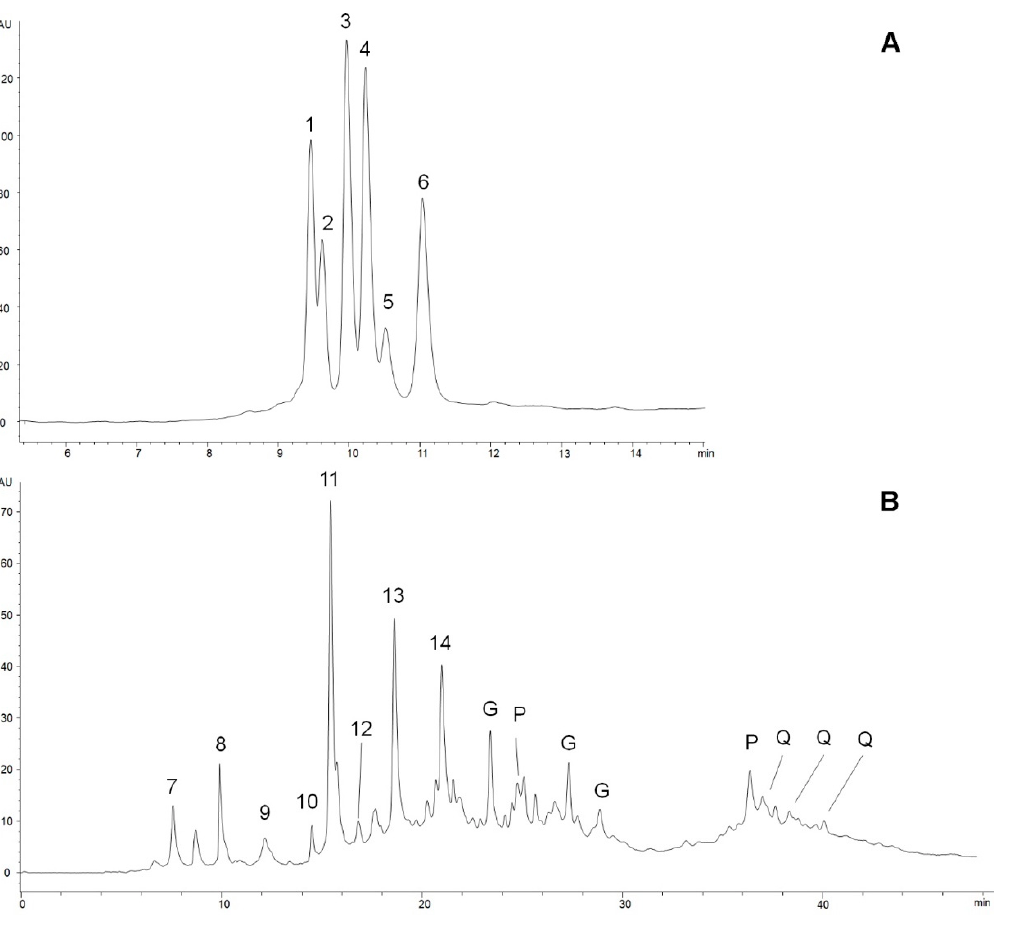
Figure 2. Chromatographic profiles of the OFS extracts (see Section 2). ( A ) pH 1.9, acquired at 520 nm: Anthocyanosidic compounds. 1. Cyanidin 3- O -galactoside; 2. Cyanidin 3- O -glucoside; 3. Cyanidin 3- O -arabinoside; 4. Peonidin 3- O -galactoside; 5. Peonidin 3- O -glucoside; 6. Peonidin 3- O -arabinoside. ( B ) pH 3.2, acquired at 280nm. Non-anthocyanosidic polyphenols. 7. Vescalin; 8. Castalin; 9. Pedunculagin I; 10. Monogalloyl glucose I; 11. Gallic acid; 12. Monogalloyl glucose II; 13. Vescalagin; 14. Castalagin; G. Gallic acid derivatives; P. Proanthocyanidins; Q. Quercetin deriv- atives. Table 1. Polyphenol content in the tested OFS. Results in mg/g powder, with absolute errors.